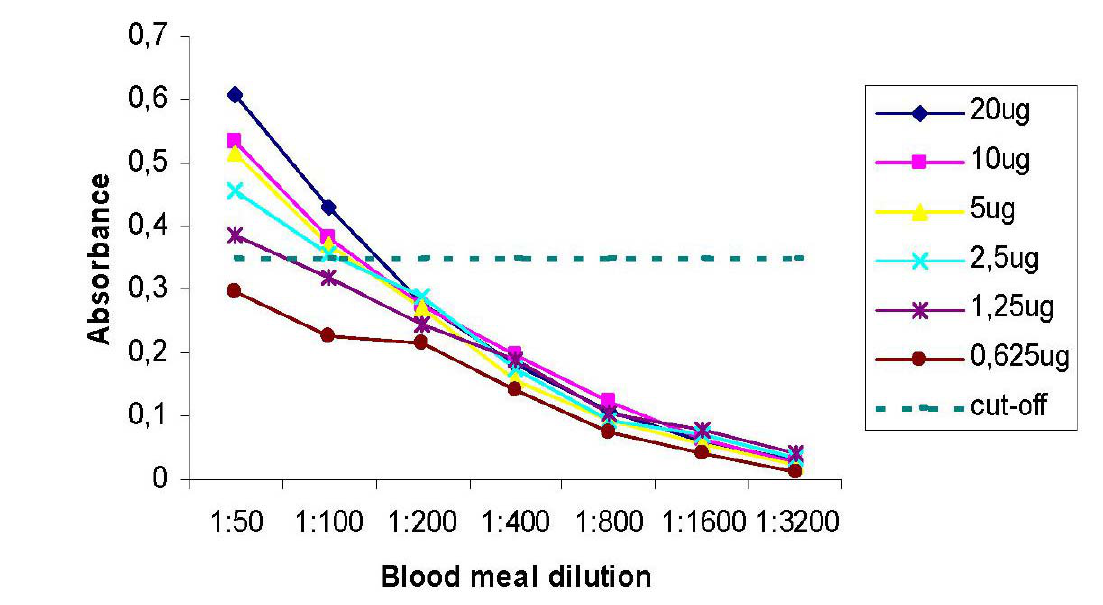
Figure 1. Optimization of the biotin/avidin ELISA assay for identifying human blood meal dilutions for Culex quinquefasciatus .